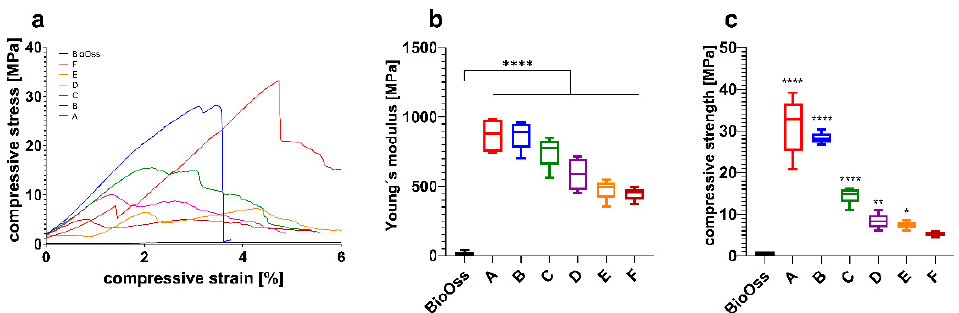
Figure 1. Three dimensional (3D) plotted scaffolds with different pore sizes. Strand-to-strand-dis- tance µm/pore size µm: ( a ) 430/100; ( b ) 560/230; ( c ) 690/360; ( d ) 820/490; ( e ) 950/620; ( f ) 1080/750. Scale bars: 2 mm.